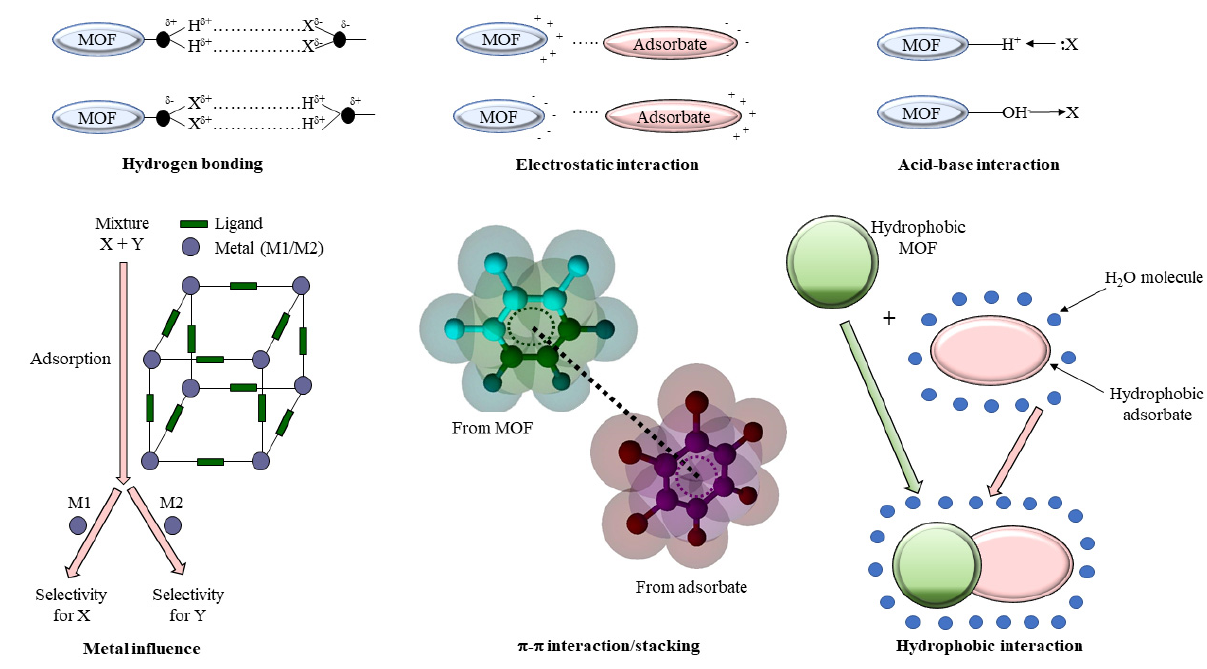
Figure 2. Adsorptive removal of CECs by MOFs based on different interactions [1].